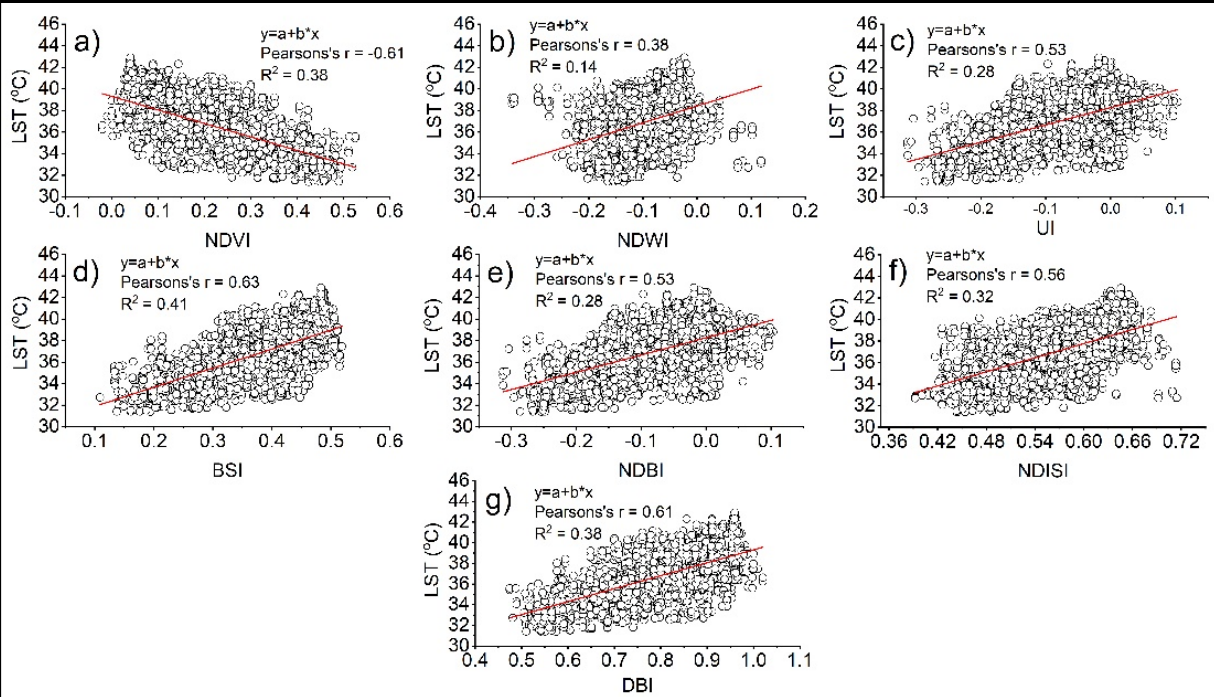
Figure 6. Relationship between LST and LULC indices in transect III ( a ) NDVI, ( b ) NDWI, ( c ) UI, ( d ) BSI, ( e ) NDBI, ( f ) NDISI, ( g ) DBI.